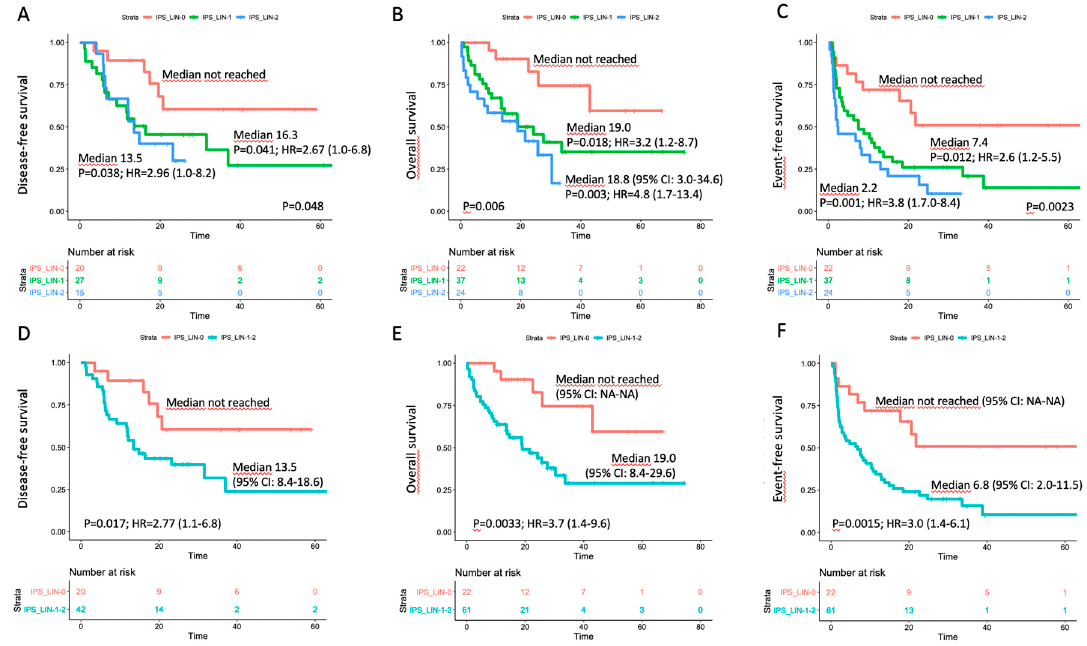
Figure 3. Survival estimates according to IPS in the triple-negative subset. Major outcomes as assessed by Kaplan–Meier curves for ( A , D ) disease-free survival, ( B , E ) overall survival, and ( C , F ) event-free survival (EFS) according to number of dysplastic lineages by immunophenotypic score (IPS) in triple-negative (TN-AML) patients. In panels ( A – C ), patients were separated in three categories; in panels D-F, IPS_1 and IPS_2 cases were grouped. Table 2. Characteristics of patients according to IPS in triple-negative disease